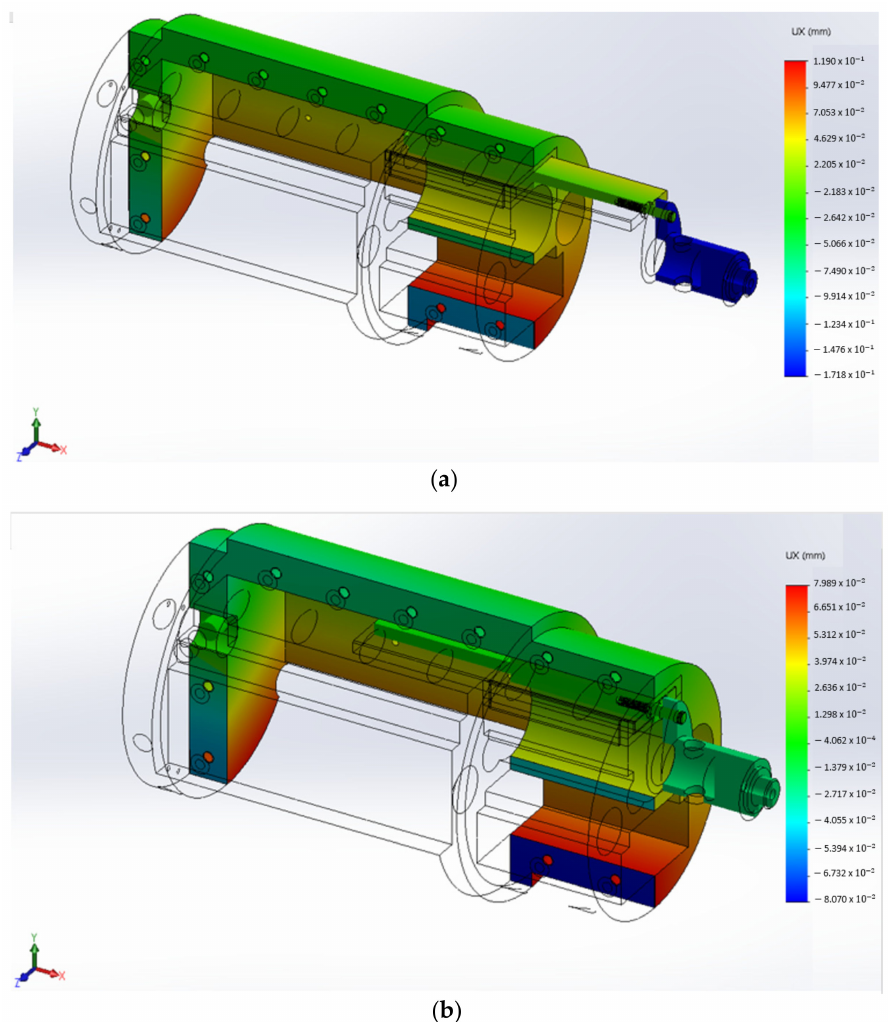
Figure 7. Displacement at X direction on the guiding element when the rod is: ( a ) extended; ( b ) retracted.